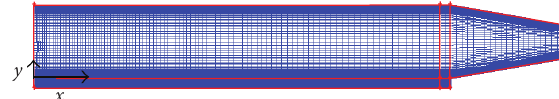
Figure 12: Discretization adopted in the analysis of CONAN experiments by the FLUENT code with conjugated heat transfer.